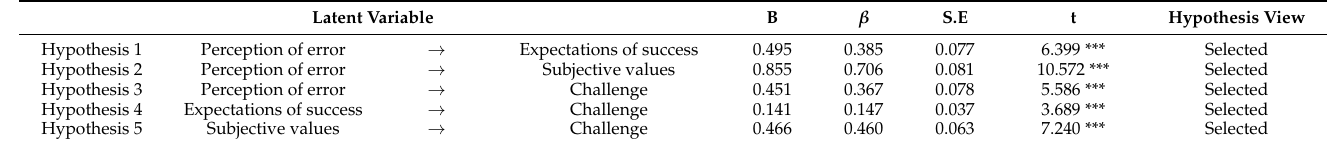
Table 6. Structural equation modeling (SEM) analysis result.